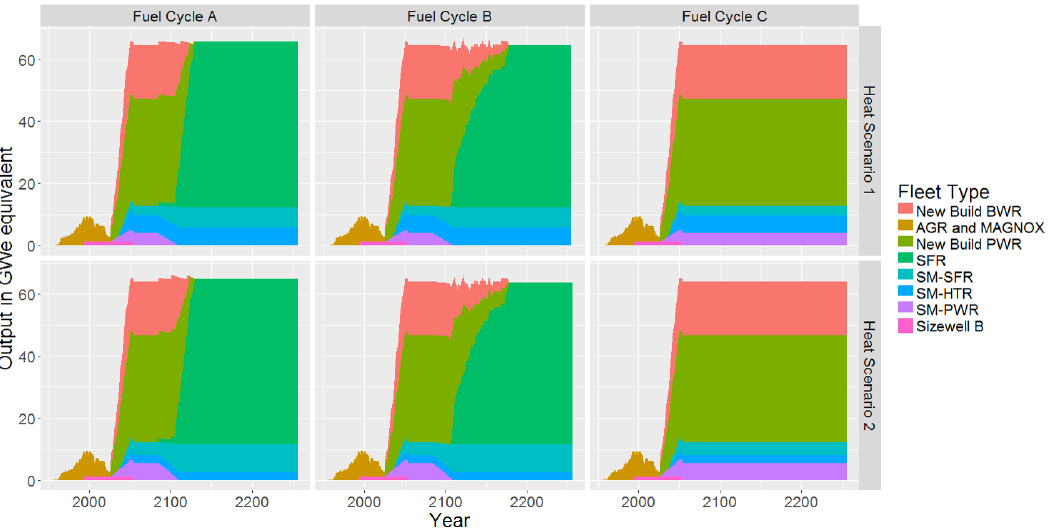
Figure 3. Deployment rates of different reactor technologies for the three fuel cycle strategies and two heat scenarios, resulting in a total of six